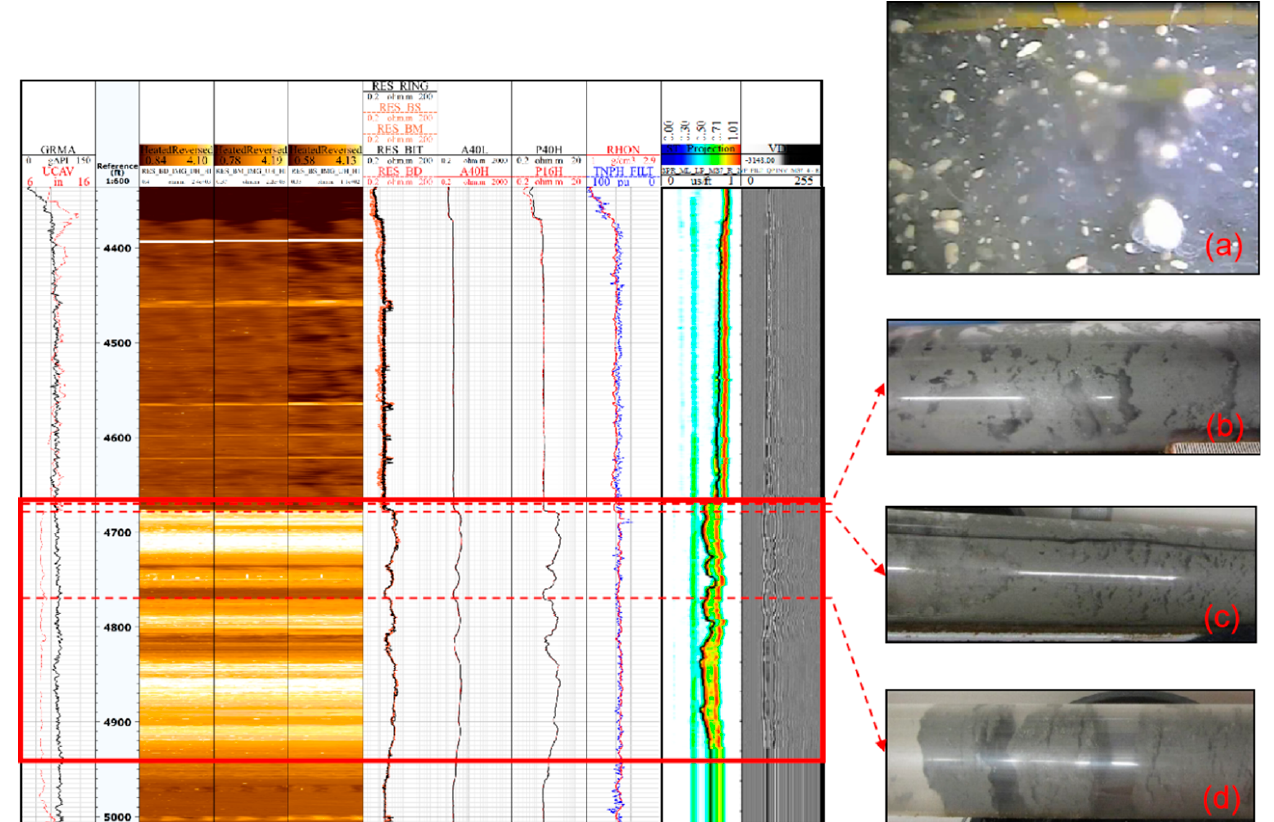
Figure 2. The LWD data and core samples at pilot Well W1: ( a ) the massive hydrate recorded by the seabed camera during the drilling process, where the gas from the hydrate decomposition caused by drilling escapes to the seabed to form hydrates again; ( b – d ) partial cores taken from the hydrate layer of well W1B at 1425.95~1426.95 m and 1429.95~1430.95 m, and from well W1C at 1458.45~1460.95 m, respectively. Due to the decomposition of hydrates, the cores are expanded, and the infrared thermal imaging of low-temperature phenomena is evident.